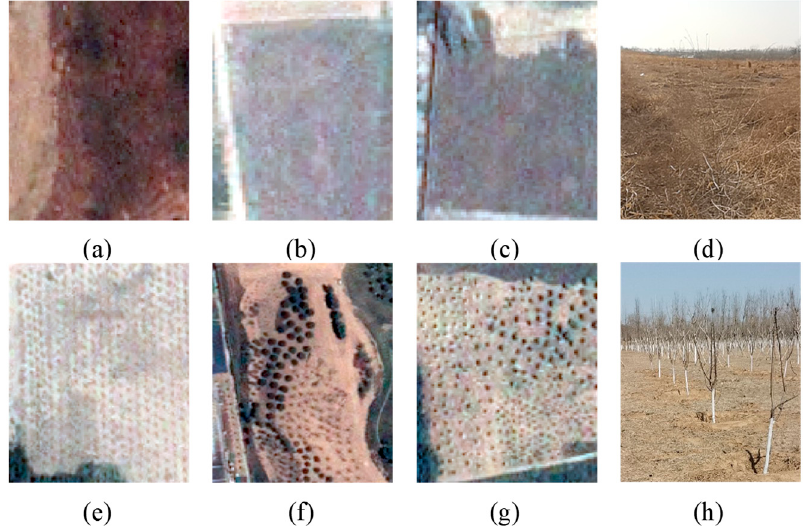
Figure 2. Examples of BLS-PG and BLS-PT areas from different places: ( a – c ) BSL-PG areas in remote sensing images; ( d ) BSL-PG areas in field survey photo; ( e – g ) BSL-PT areas in remote sensing images; ( h ) BSL-PT areas in field survey